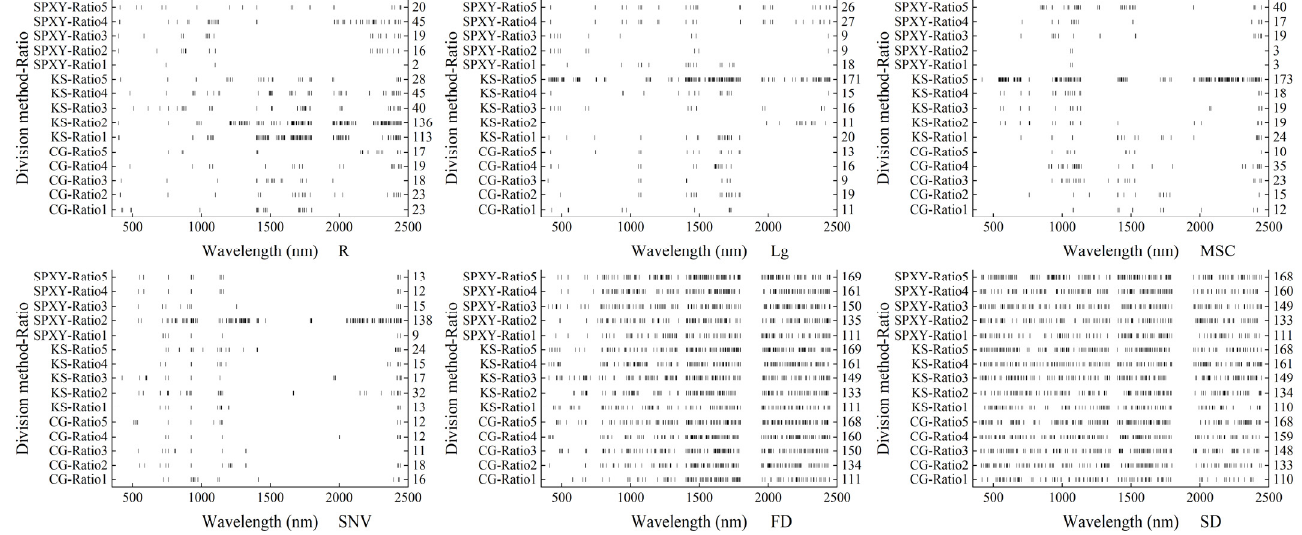
Figure 6. SMLR modeling bands based on full-spectrum bands.